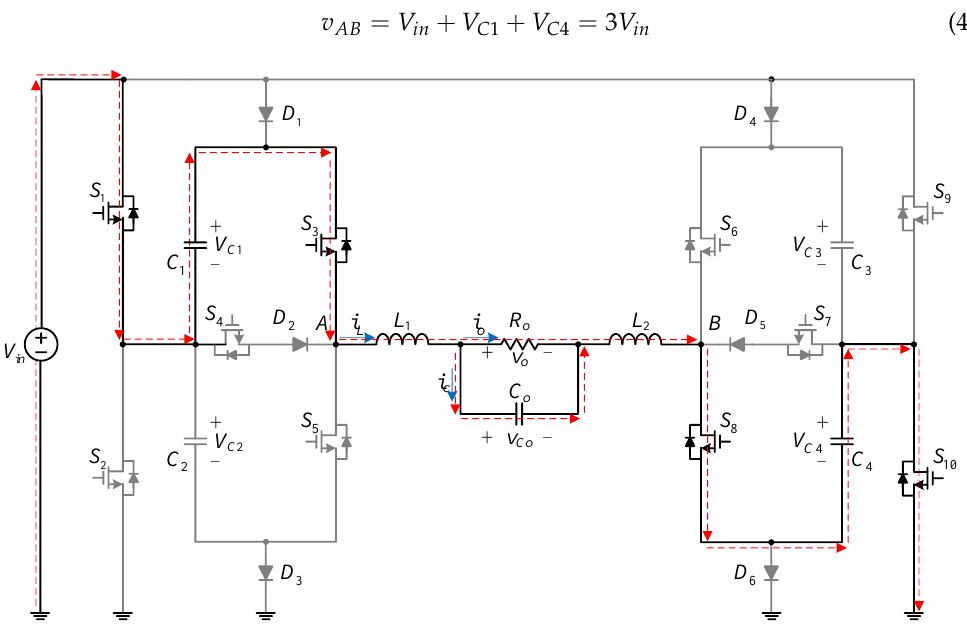
Hence, the voltage on the terminals of A and B , called v AB , is: